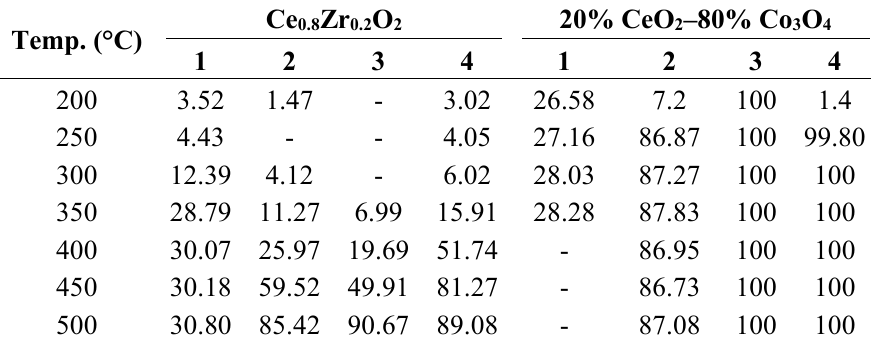
Table 4. The influences of co-existing gases (CO, H 2 O) and oxygen concentrations on catalytic activities (propylene conversion, %) of some potential chemical mixtures of CeO 2